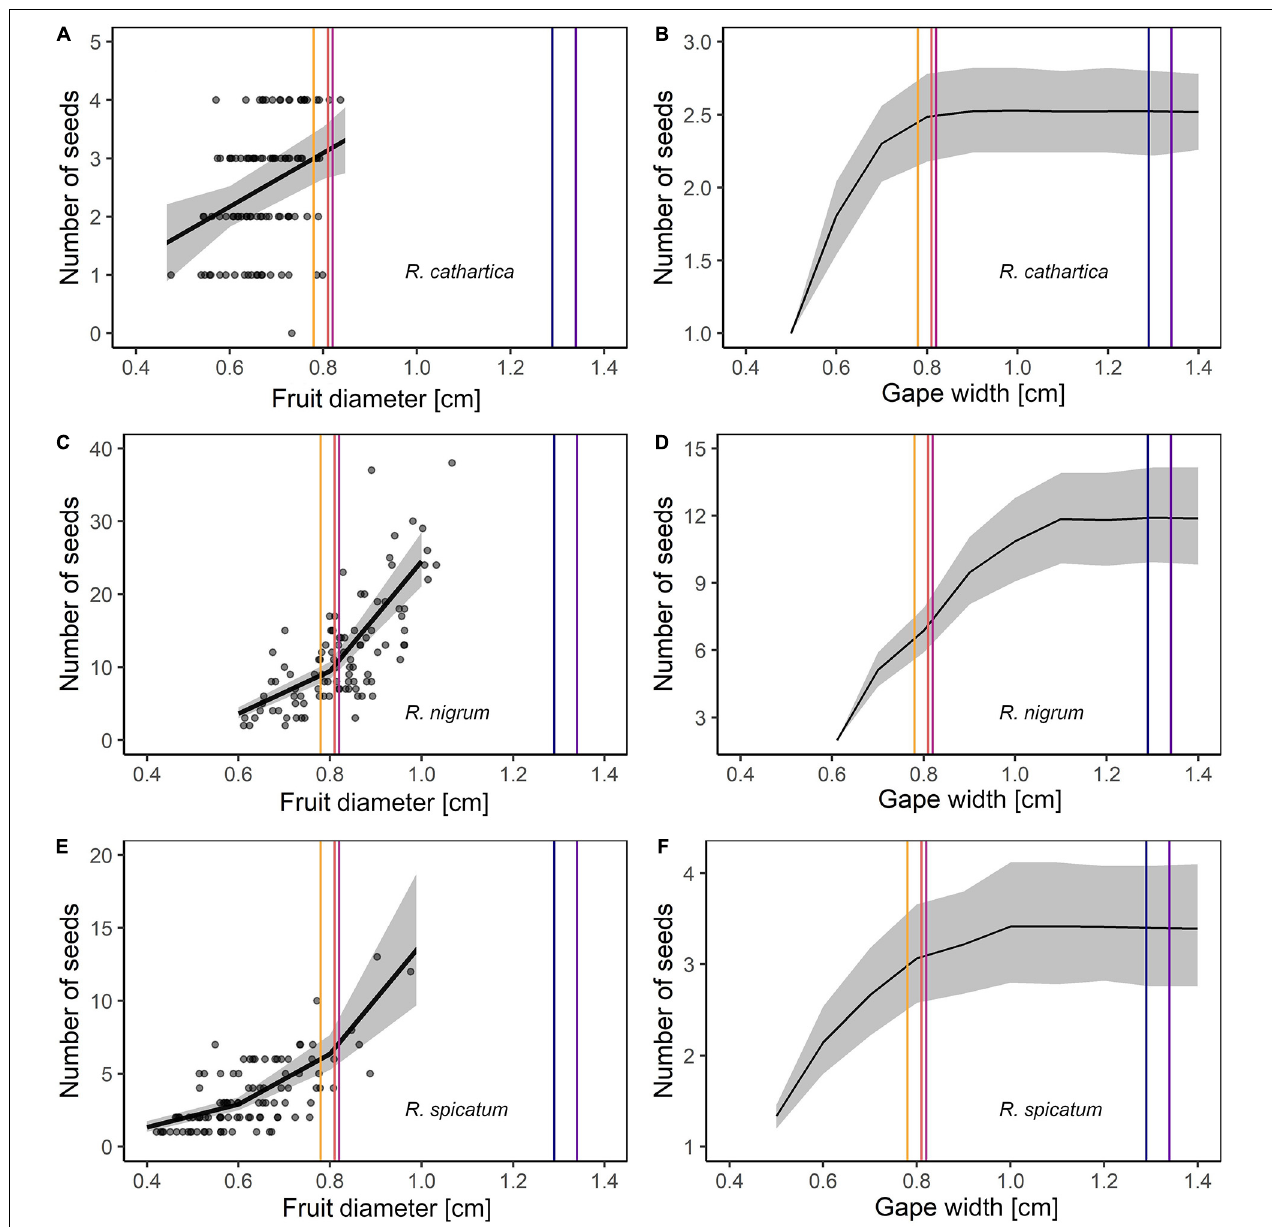
FIGURE 5 | (A,C,E) The number of seeds per fruit in relation to fruit diameter and (B,D,F) the predicted number of seeds per fruit taken up by animals depending on their gape width in Rhamnus cathartica (A,B) , Ribes nigrum (C,D) and Ribes spicatum (E,F) . The number of seeds per fruit was not related to the diameter of fruits in the other study species in Białowie˙za Forest, Poland. Shaded areas indicate the 95% confidence intervals. The colored vertical lines display the mean gape width of the most important animal dispersers of the plant species (but M. martes with a gape width > 2 cm). Please see Figure 2 for more